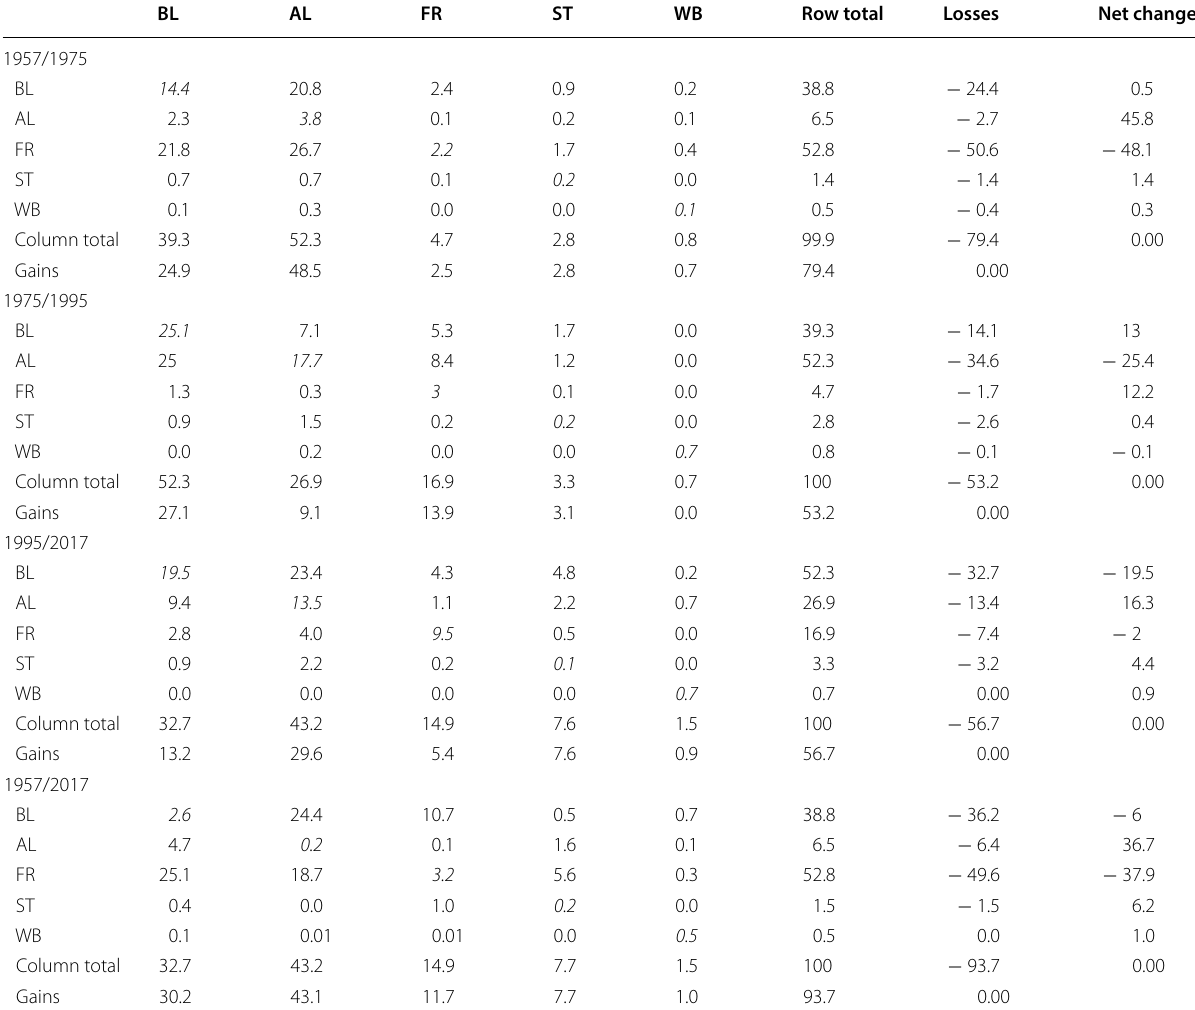
Table 4 Land use/land cover change flow matrices for each period (%)